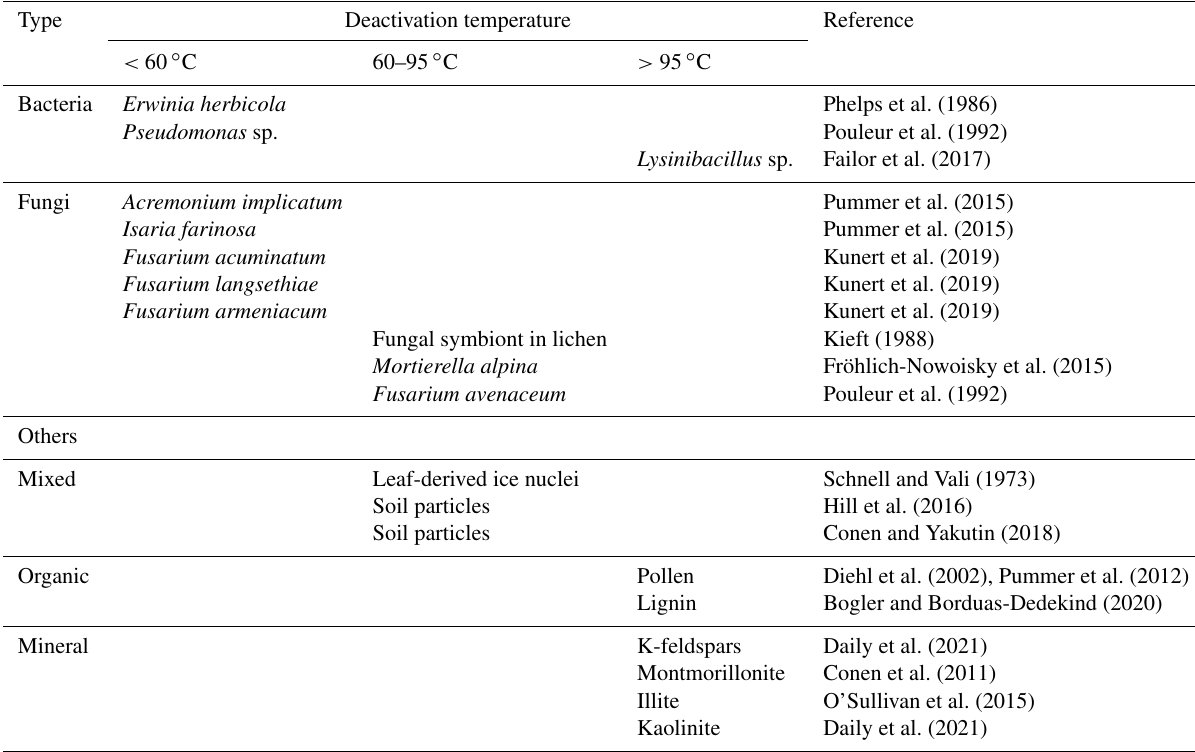
Table 2. Reported heat sensitivity of INPs active at moderate supercooling. Indicated is the temperature range in which at least 90% of a specific type of INPs active ≥ 15 ◦ C was found to be deactivated, although a smaller fraction of the same INPs may already have been deactivated at a lower temperature. For example, soil particles analysed by Conen and Yakutin (2018) had lost half of their INP − 10 after exposure to 60 ◦ C but more than 98% after exposure to 95 ◦ C. These particles are assigned a deactivation temperature between 60 and 95 ◦ C. Note that studies where INPs were found to be deactivated after a single heat treatment ∼ 95 ◦ C are not listed because deactivation might already have happened < 60 ◦